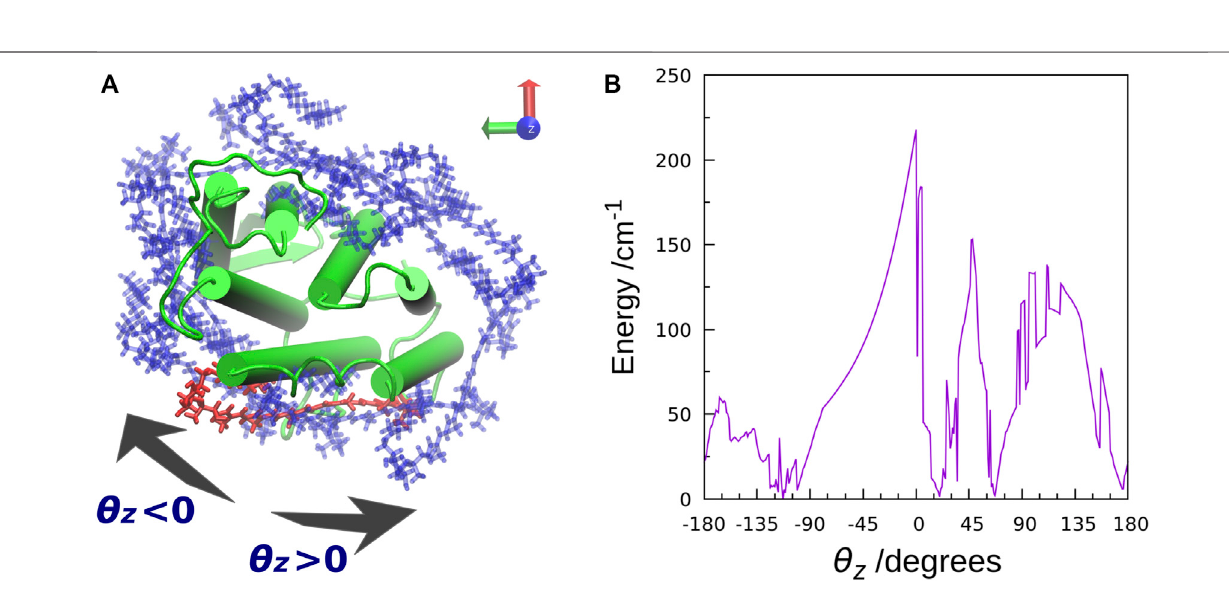
FIGURE 6 | (A) Top view of the salinixanthin orientations generated around the XR protein using Euler angles. The rotation angle is taken as θ z . The native salinixanthin structure is shown in red, which is set to θ z (cid:1) 0. (B) Calculated electronic coupling energy between salinixanthin and retinal as a function of θ z .